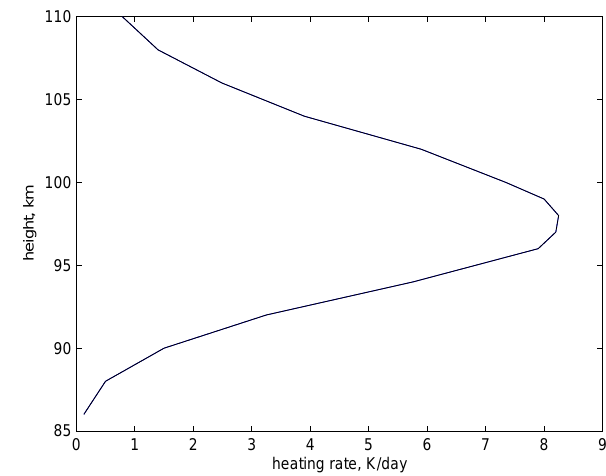
Fig. 1. Temperature height profiles observed by Yu and She (1995) (solid curve) and given by the MSISE-90 model (dashed curve).